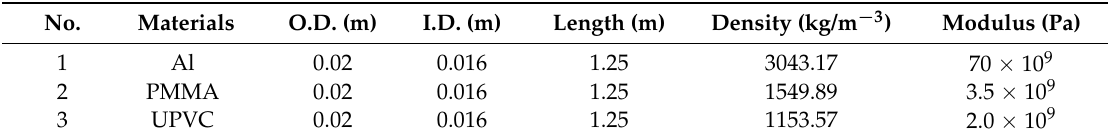
Table 1. Geometries and properties of the risers.